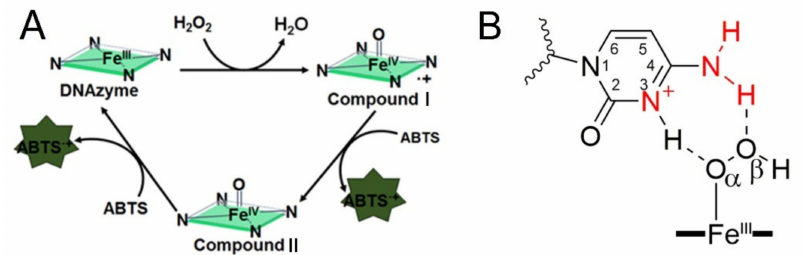
Figure 1. ( A ) Traditional peroxidation cycle facilitated by G-quadruplex DNAzyme for the ABTS-H 2 O 2 reaction. ( B ) Proposed intermediate catalytic process, which is assisted with proximal flanking